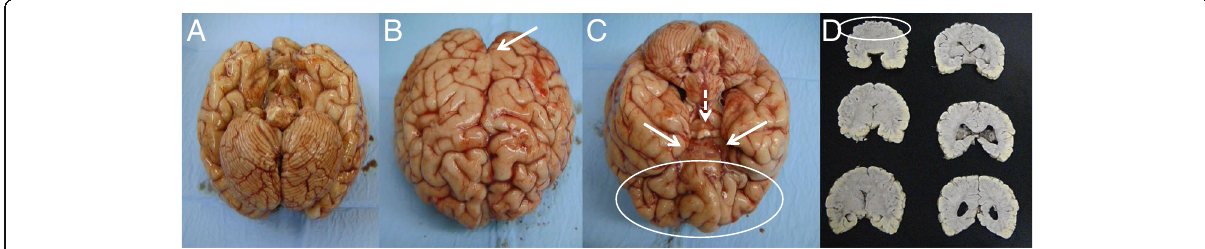
Fig. 2 a Development of the cerebellum appears normal. b Both hemispheres are fused up to the gyrus centralis ( arrow ) with presence of polymicrogyria. c Fusion of the anterior brain is encircled. Bulbus olfactorius is bilaterally absent ( arrows ) while the chiasma opticum is normal ( dashed arrow ). d Sequential coronal sections of the brain demonstrate the incomplete separation common to semilobar HPE. Inter-hemispheric fissure is invisible in the anterior brain (region encircled). The ventral horns of the lateral ventricle are absent, as well as the genu of the corpus